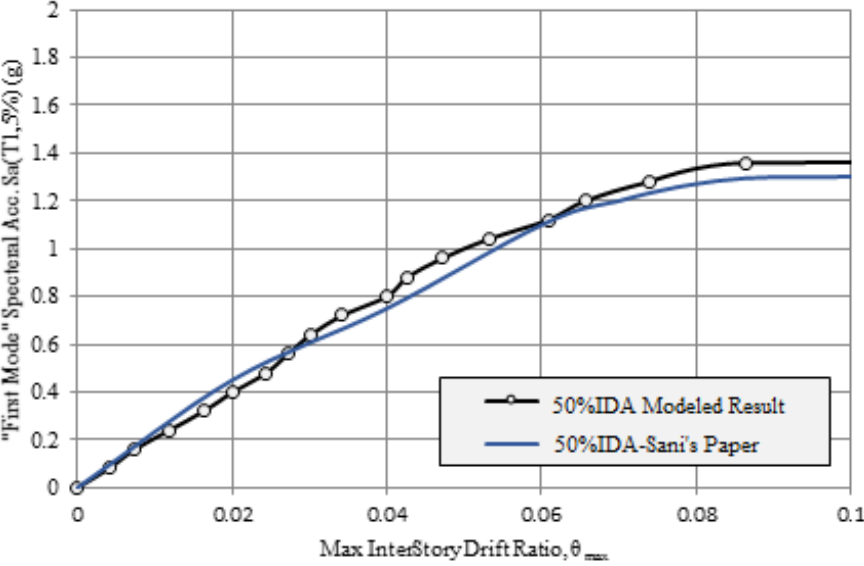
Figure 22. Comparison between 50% IDA curves.